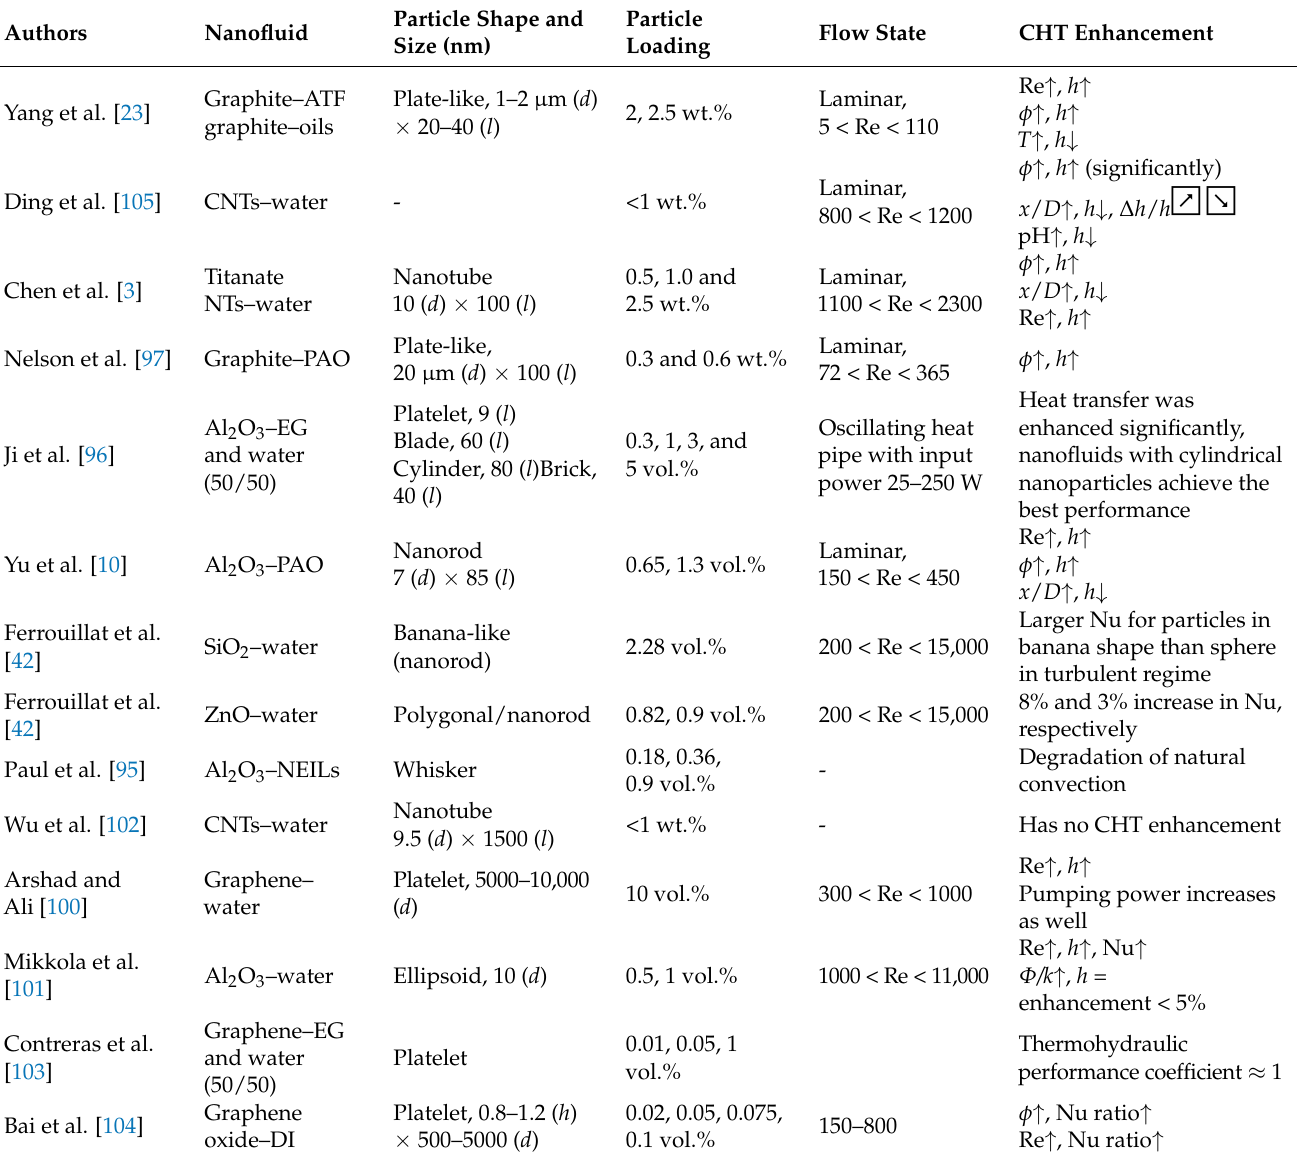
Table 3. Experimental studies for CHT of NSN